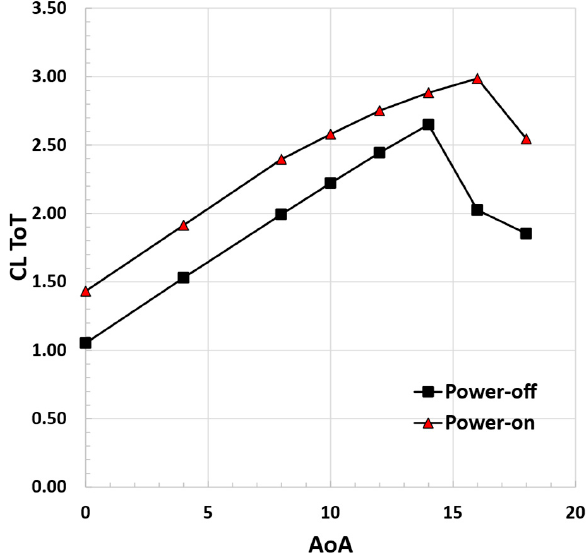
Figure 21. Total lift coefficient curves for power-off and power-on take-off conditions, M = 0.15, Re = 5.7 × 10 6 , J TIP = 0.78, rpm TIP = 1600, J DEP = 0.89, rpm DEP = 2000.